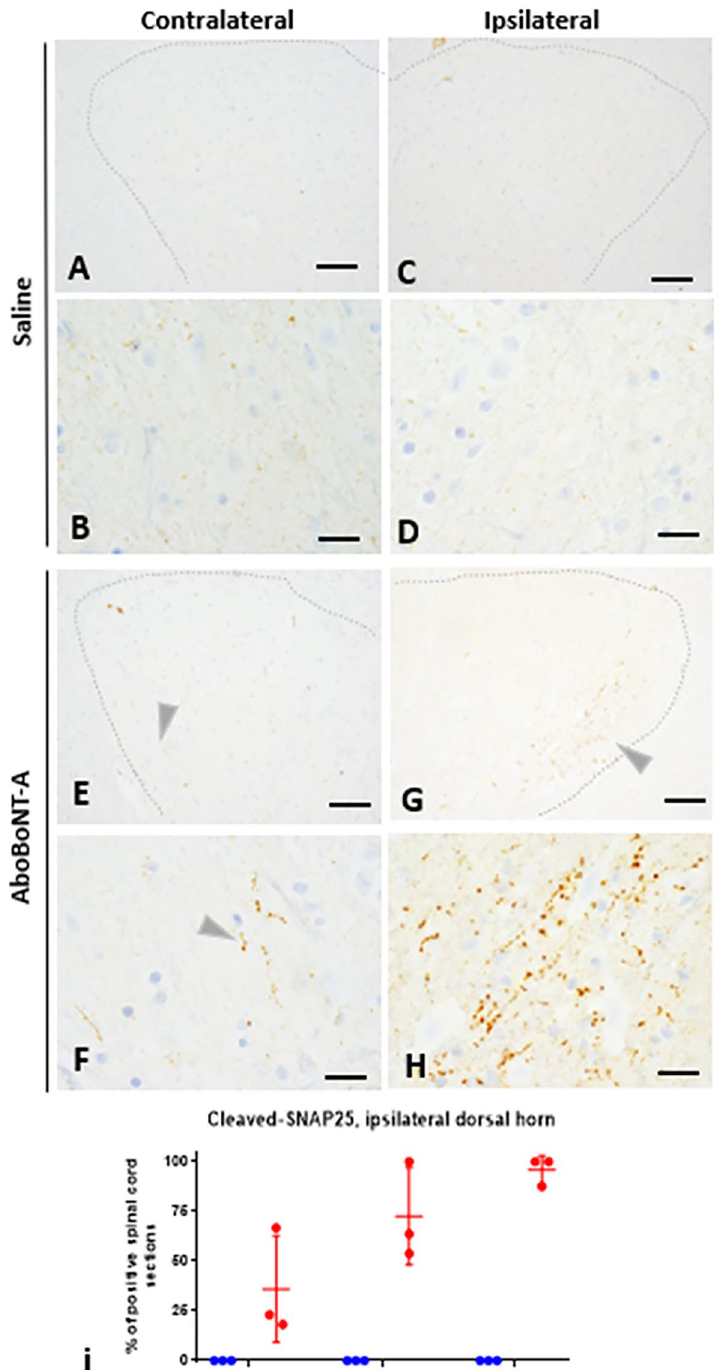
Figure 4. Assessment of cleaved SNAP25 immunolabelling in the spinal cord of saline- and aboBoNT-A treated animals. Photomicrographs depict lack of cleaved SNAP25 immunolabeling in the dorsal horn of the lumbar spinal cord contralateral ( A, B ) and ipsilateral ( C, D ) to the incision (see text) in a representative animal that received a full-skin and muscle incision and retraction surgery (Day 0), followed by intraoperative treatment with saline. Also, photomicrographs depict presence of cleaved SNAP25 immunolabeling in the dorsal horn of the lumbar spinal cord ipsilateral ( G, H ) and contralateral ( E, F ) to the incision in a representative animal that received a full-skin and muscle incision and retraction surgery (Day 0), followed by intraoperative treatment with aboBoNT-A 400 U. In all aboBoNT-A-treated animals, cleaved SNAP25 was detected in the lateral part of the ipsilateral dorsal horn ( G ; arrowhead), corresponding to the substantia gelatinosa of Rolando. In the contralateral dorsal horn ( E, F ; arrowhead) a minimal staining was present in the same location. Panel I shows quantification of positive spinal cord sections for cleaved SNAP25 from lumbar (L) sections 1–2, 3–4, and 5–6 obtained from three representative animals treated with saline (blue symbols) and aboBoNT-A (red symbols), as well as their mean values (± SEM). Size bars: 100 µm ( A, C, E, G ) or 20 µm ( B, D, F, H ). AboBoNT-A, abobotulinumtoxinA; U,